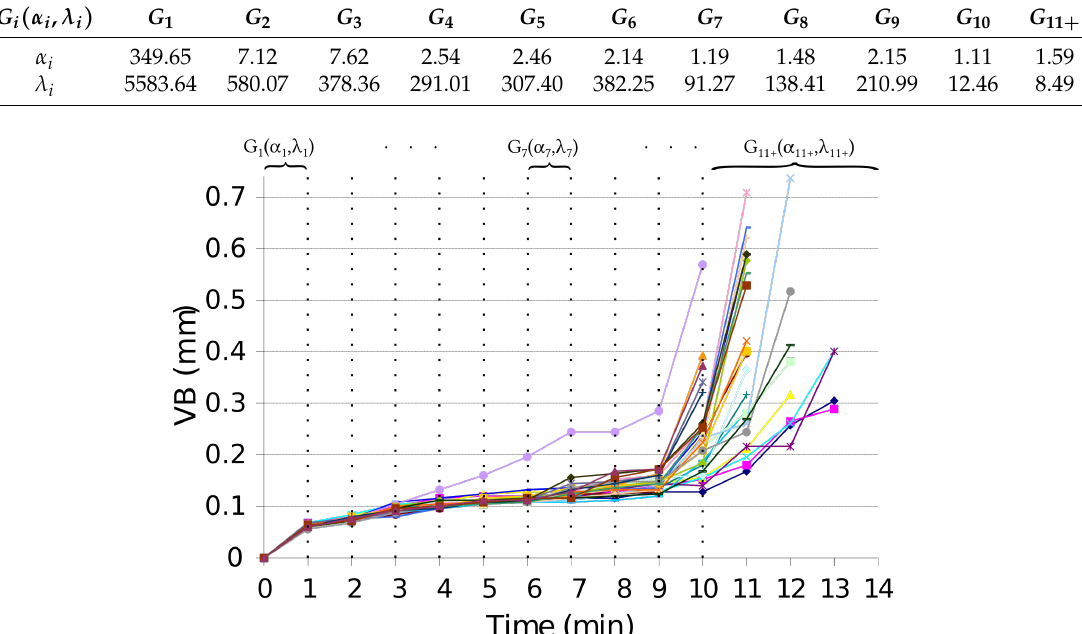
Table 1. Parameters of the piecewise linear gamma process. Data from [34].